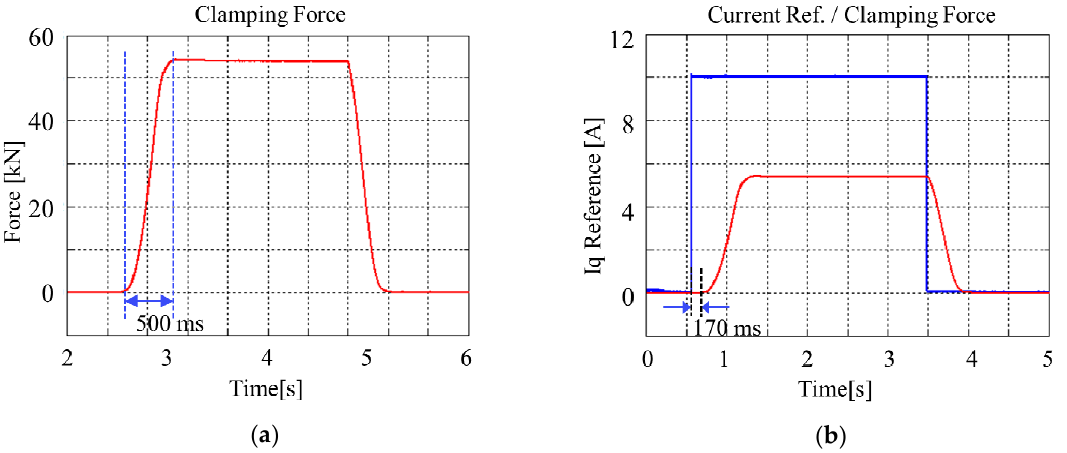
Figure 13. Concept diagram for proposed PI controller using anti-windup feedback control.